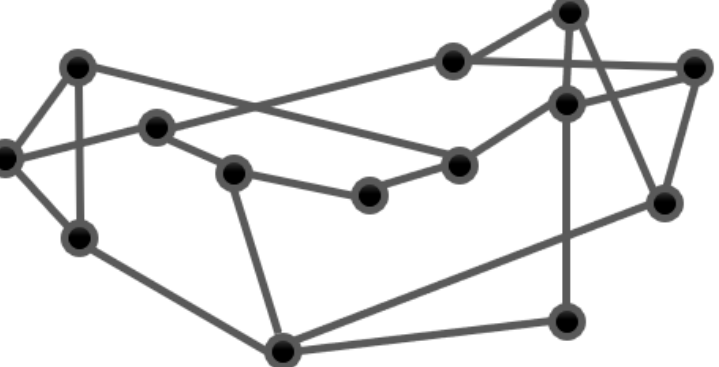
Figure 2. NSFNET topology. It contains 14 switches and 21 links, all with a link bandwidth of 10 Mbps, where each switch connects to a host for receiving and sending